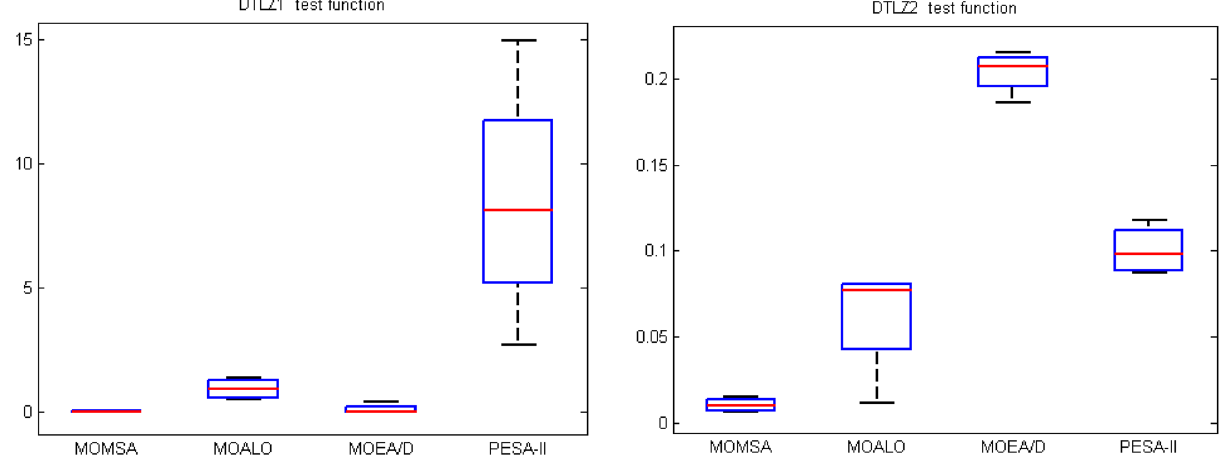
Figure 10. Boxplot of the statistical results for S evaluation metrics on DTLZ1 and DTLZ2 tri-objective test